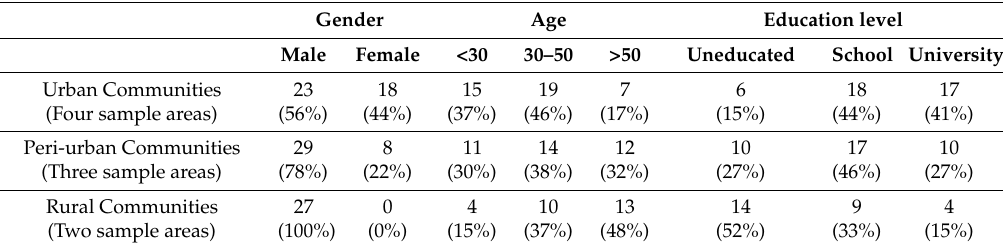
Table 1. Characteristics of volunteers who mapped case study areas.